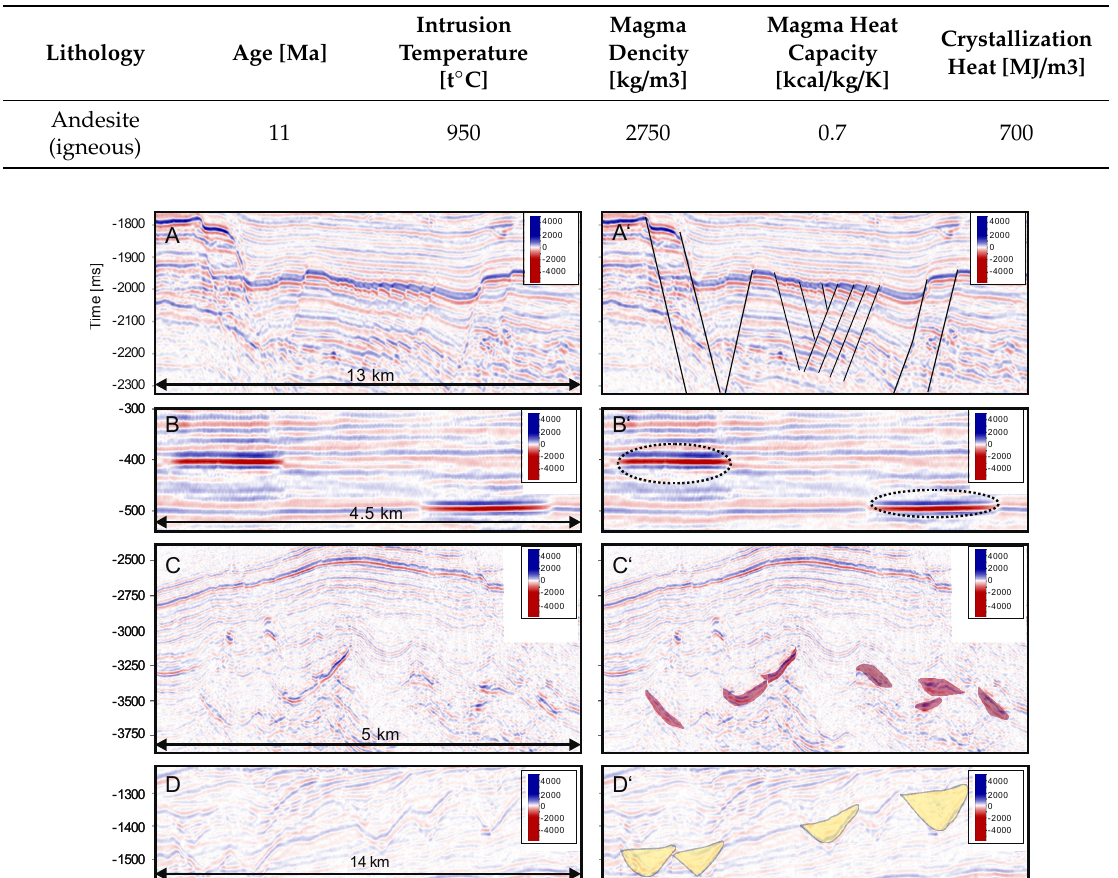
Figure 7. Seismic section illustrating the seismic anomalies captured within the 3D data set. All the seismic sections are in time. See ( A ) Normal faulting; ( B ) Bright spots; ( C ) Volcanic intrusions; ( D ) Channels in the different sections.